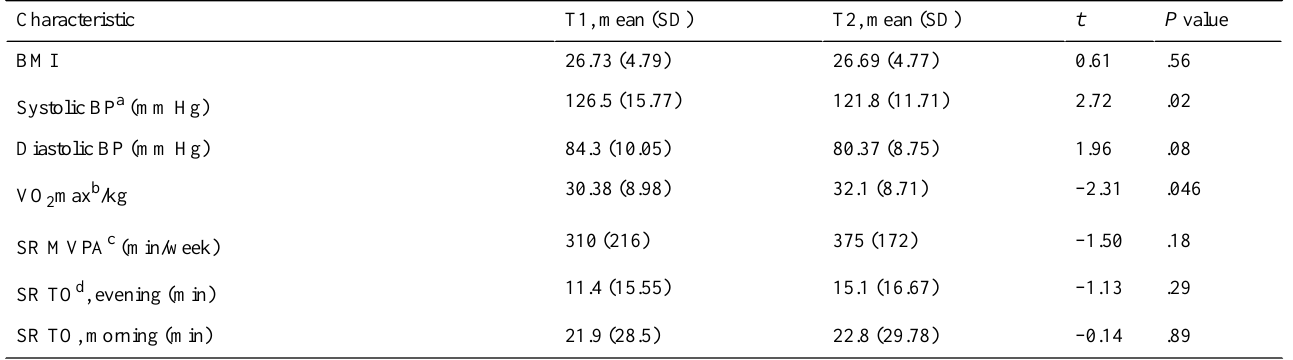
Table 1. Pre-post measurements in the physical activity group.